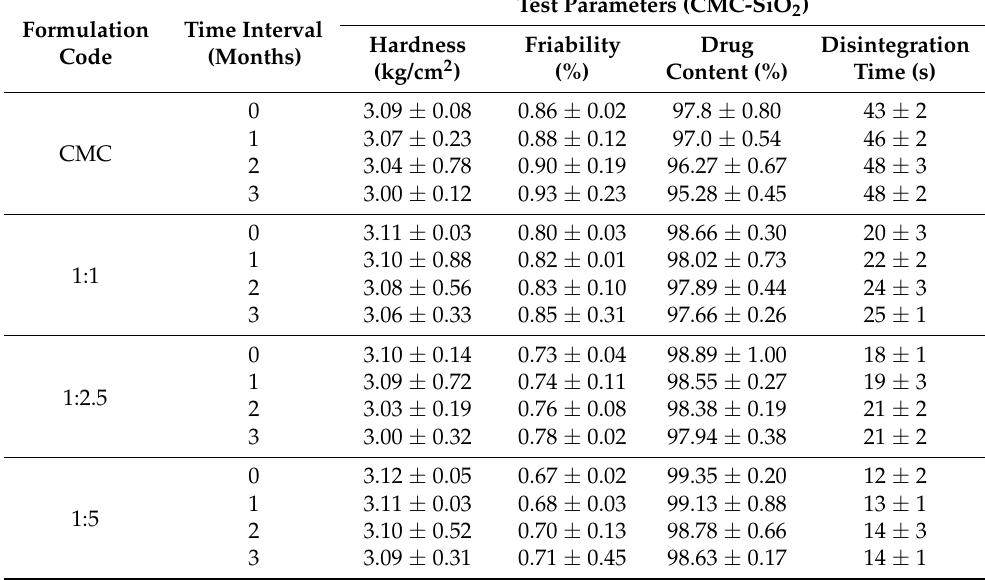
Table 10. Stability study for the prepared CMC-SiO 2